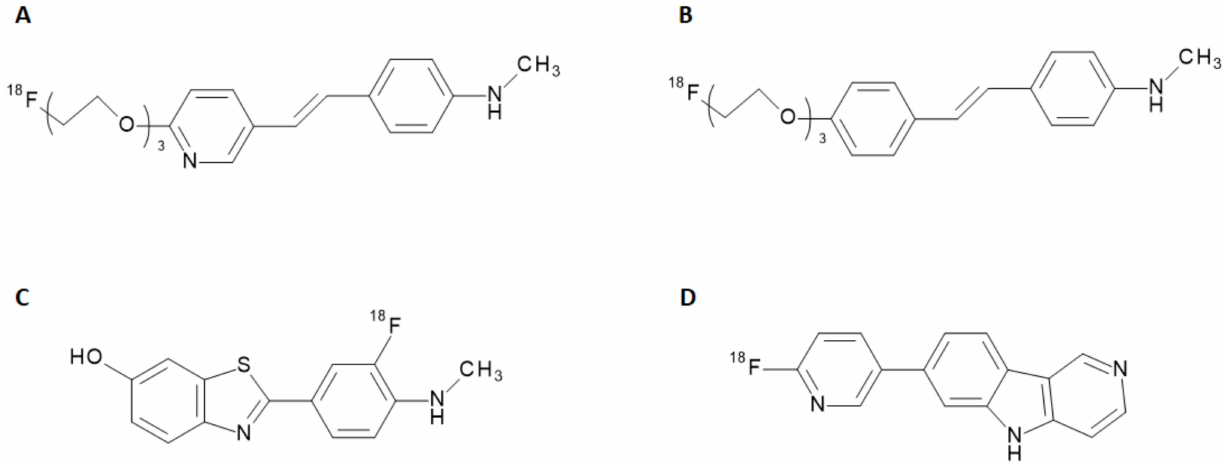
Figure 1. Chemical structure of [ 18 F]-florbetapir (Amyvid) ( A ), [ 18 F]-florbetaben (Neuraceq) ( B ), [ 18 F]-flutemetamol (Vizamyl) ( C ), and [ 18 F]-flortaucipir (Tauvid) ( D